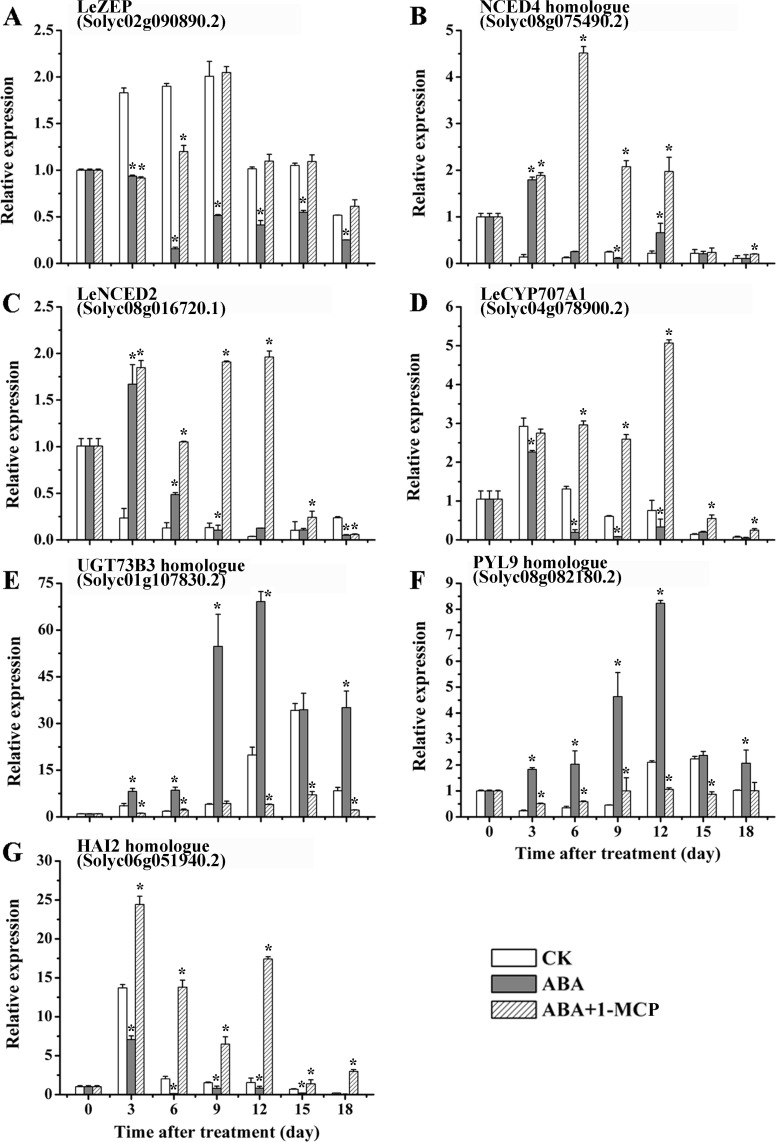
The expression of DEGs related to ABA metabolism and signaling in CK, ABA and (ABA+1-MCP)-treated fruits at different ripening stages.RT-PCR analysis of ZEP (A), NCED4 (B), NCED5 (C), ABA80X (D), UGT73B3 (E), PYL9 (F) and HAI2 (G) were conducted in CK vs ABA and CK vs ABA+1-MCP treatment. Other details are the same as in Fig 5.